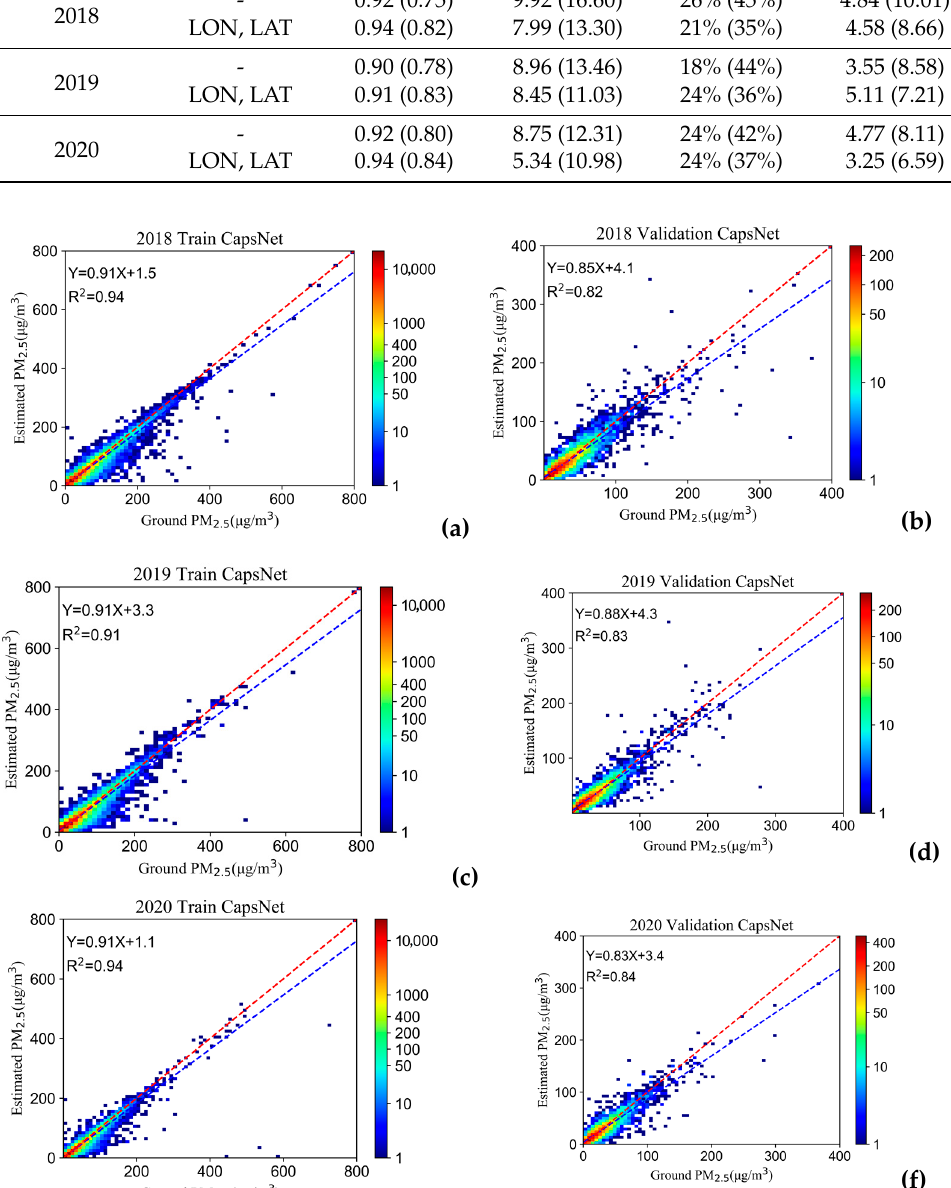
Figure 5. Density scatter of CapsNet model training and validation. The blue and red lines indicate the fitted line and 1:1, respectively. ( a , c , e ) are the training result density scatter in 2018–2020; ( b , d , f ) are the validation result density scatter in 2018–2020. Y and X are estimated and Ground PM 2.5 ,